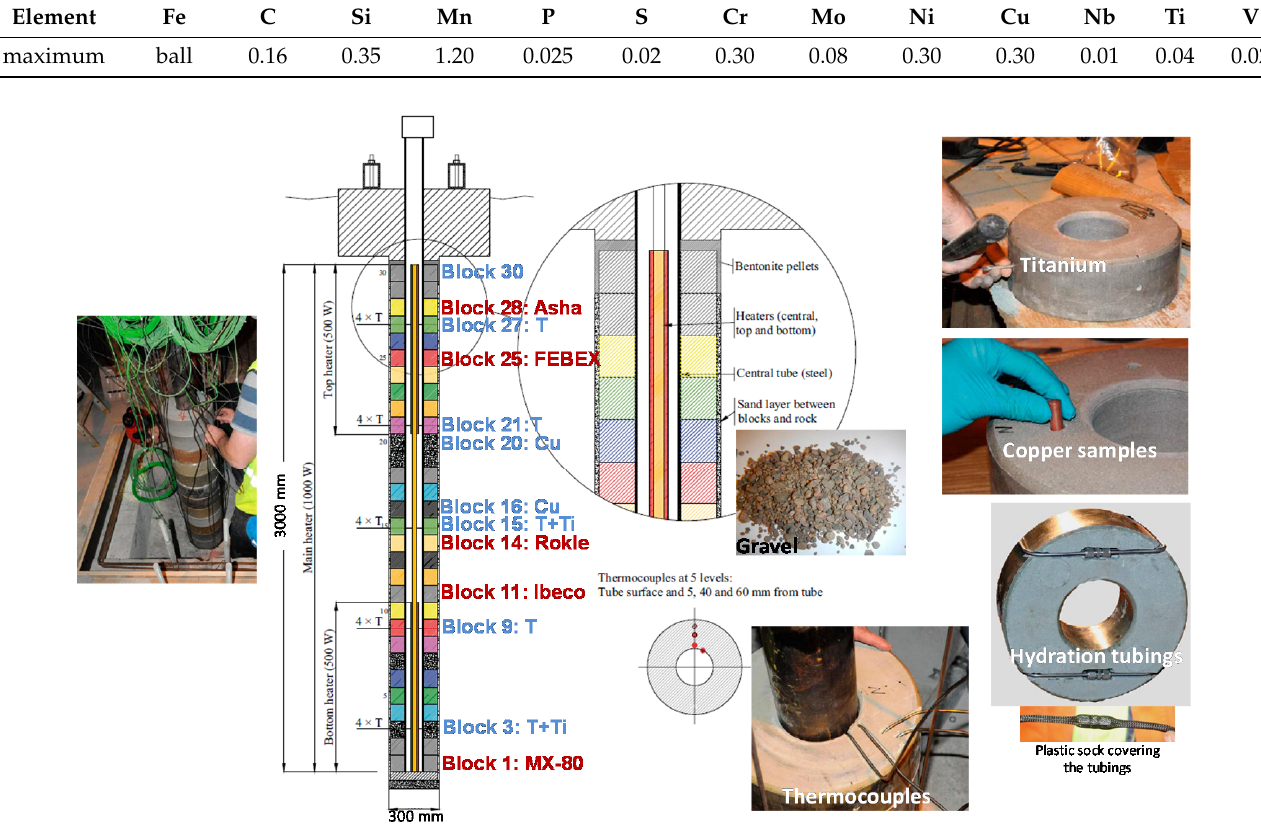
Figure 1. Schematic design of the ABM5 test package (after [16], courtesy of SKB). In red: samples analysed in this study. In blue: block containing thermocouples and Cu and Ti coupons. Colours represent different types of